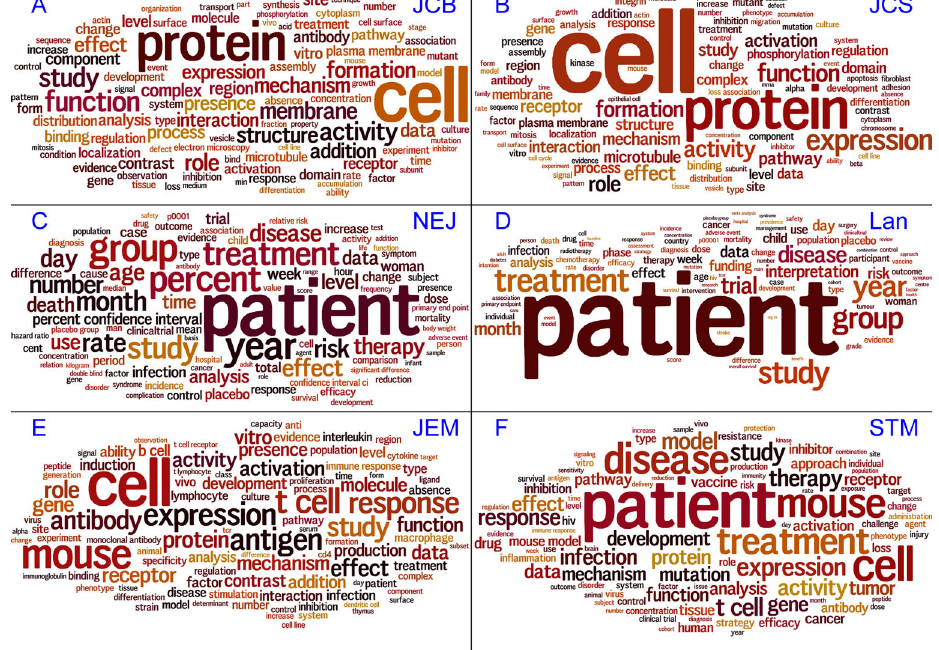
Figure 1. Vocabulary comparison between cell biology, medical, and translational journals using word clouds. There was a remarkable vocabulary similarity between Journal of Cell Biology (JCB) and Journal of Cell Science (JCS), as well as between New England Journal of Medicine (NEJ) and Lancet (Lan). Both Journal of Experimental Medicine (JEM) and Science Translational Medicine (STM) showed a mixture of most frequent words from cell biology and medical journals.